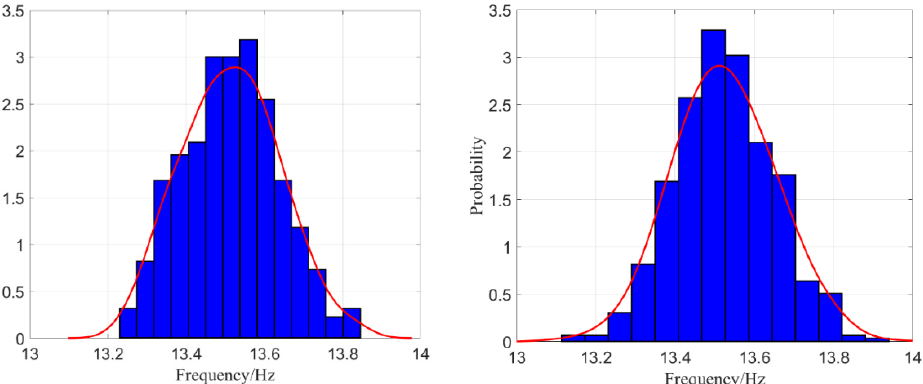
ρ are random fields: 15 15 × elements